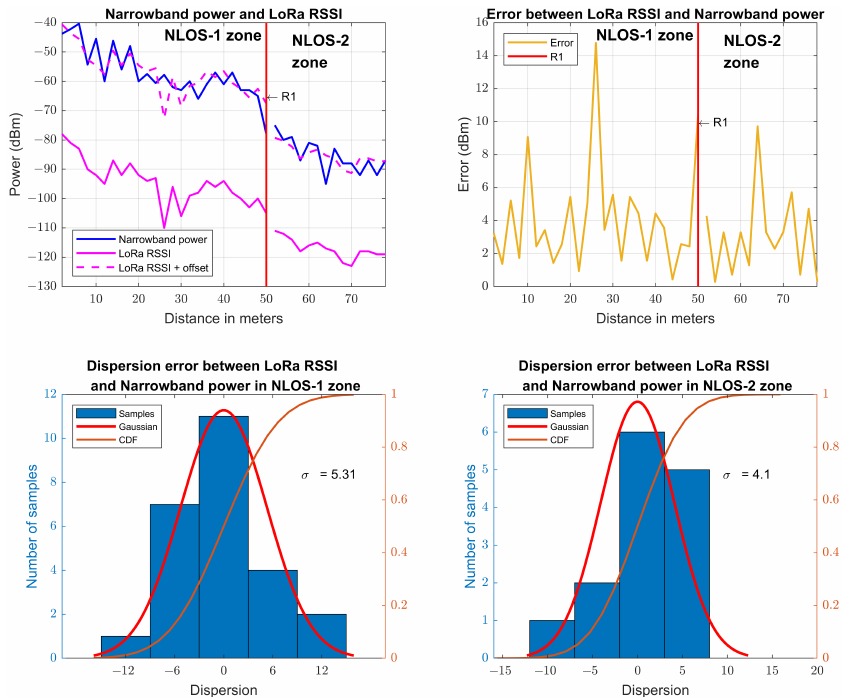
Figure 13. Comparison of narrowband transmission received power and LoRa RSSI.